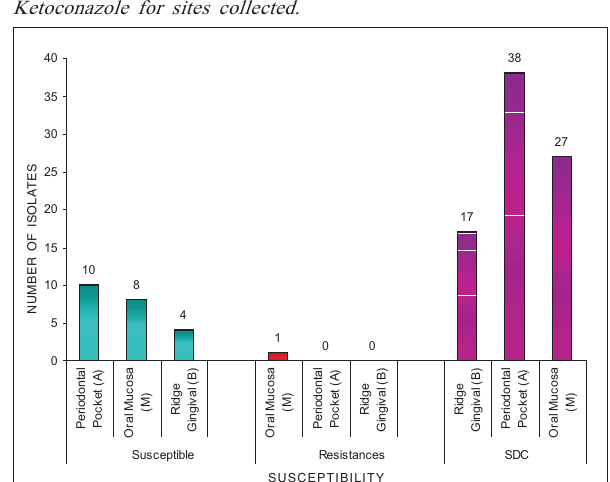
Fig.3a - Susceptibility of C. albicans isolates to Itraconazole for sites collected.